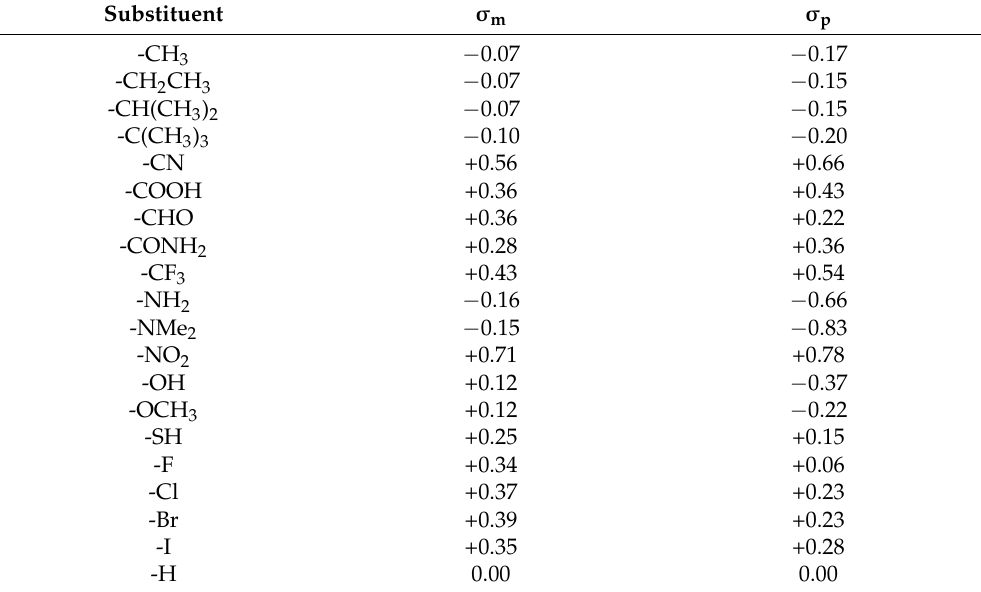
Table 3. Values of some Hammett substituent constants ( σ )